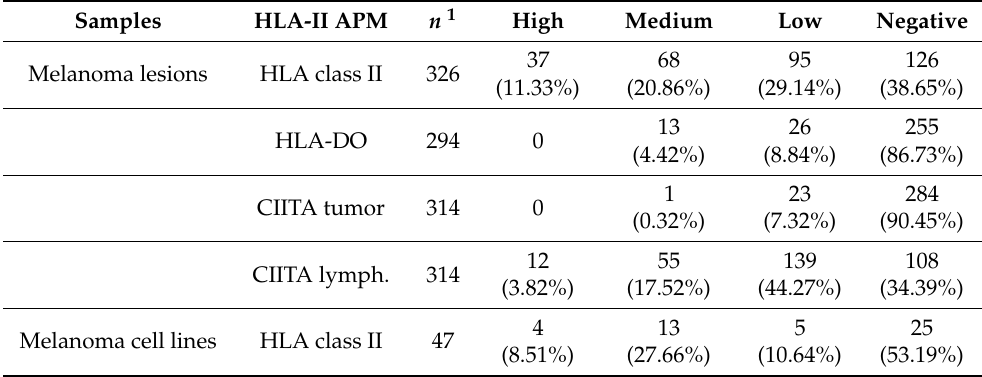
Figure 1. Representative immunohistochemical analysis of HLA class II antigens on melanoma lesions. IHC analysis was performed as described in Materials and Methods. Tissues were stained with the anti-HLA class II antibody LGII-612.14. Shown are representative stainings of a HLA class II negative (spot 150), HLA class II medium (spot 163) and HLA class II high (spots 7 and 259) expressing lesions. Scale bar: 100 µm. Table 1. Distinct protein expression pattern of HLA class II antigens and/or APM components in melanoma lesions and melanoma cell lines.